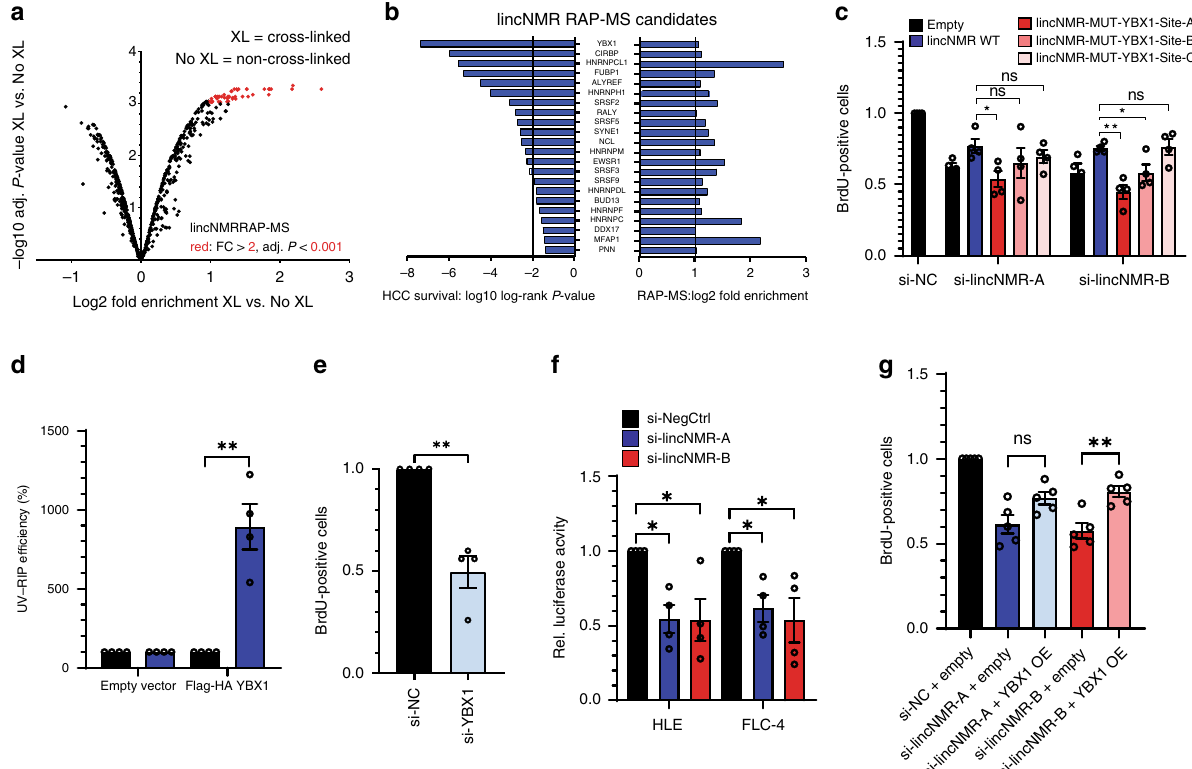
Fig. 3 lincNMR directly binds to and controls YBX1. a Volcano plot depicting total candidates ( n = 701) identi fi ed by lincNMR in vivo RNA antisense puri fi cation followed by mass spectrometry (RAP-MS). In total, 48 candidates highlighted in red were selected for fold enrichment (FC > 2) and adjusted P - value of enrichment ( P < 0.001). XL: cross link. Signi fi cance was calculated by moderated t test. b Interaction candidates identi fi ed by in vivo RAP-MS selected for fold enrichment in cross linked over non-cross linked samples (FC > 2), adjusted P - value of enrichment ( P < 0.001), and sorted for log-rank P - value in liver cancer patient survival (based on TCGA data). c While the overexpression of wild-type (WT) lincNMR partially rescues the decreased cell proliferation caused by lincNMR knockdown, a lincNMR mutant with a mutation in the fi rst (A) of three (A, B, C) putative YBX1-binding sites is not capable of rescuing cell proliferation in HLE cells at 72 h post lincNMR depletion (assayed by BrdU incorporation, n = 4). d Determination of RNA pull down ef fi ciency in UV – RIP by RT-qPCR validating the interaction between YBX1 and lincNMR in HLE cells ( n = 4). Data shown are normalized to SRSF4 as a negative control gene and control vector. e Silencing YBX1 with 10 nM siPOOL imparts a proliferative disadvantage to HLE cells determined 72 h post transfection ( n = 4). Data shown are normalized to negative control siPOOL. f Dual-luciferase assay for the transactivational activity of YBX1, which unravels the inhibition of YBX1 by lincNMR silencing. Data shown are the normalized ratios of YBX1-dependent Fire fl y luciferase activity divided by Renilla luciferase used for standardization after depletion of lincNMR with 10 nM siPOOLs in HLE and FLC-4 cells ( n = 4). g Overexpression of YBX1 partially rescues the proliferation defect induced by lincNMR depletion in HLE cells assayed by BrdU cell proliferation assay (72 h depletion of lincNMR and 66 h overexpression of YBX1). Data shown are normalized to empty vector transfected with negative control siPOOL ( n = 5). c – g Data represents mean and error bars represent SEM. Signi fi cance was calculated by unpaired, two-tailed t test with * P < 0.05; ** P < 0.01; *** P <